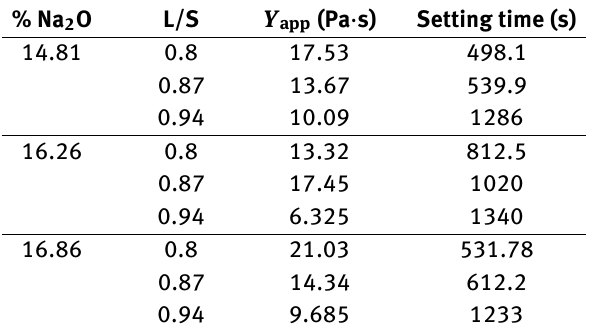
Table 3: the values of the correspondence between the apparent viscosity and the setting time % Na 2 O L/S Υ app (Pa · s) Setting time (s)